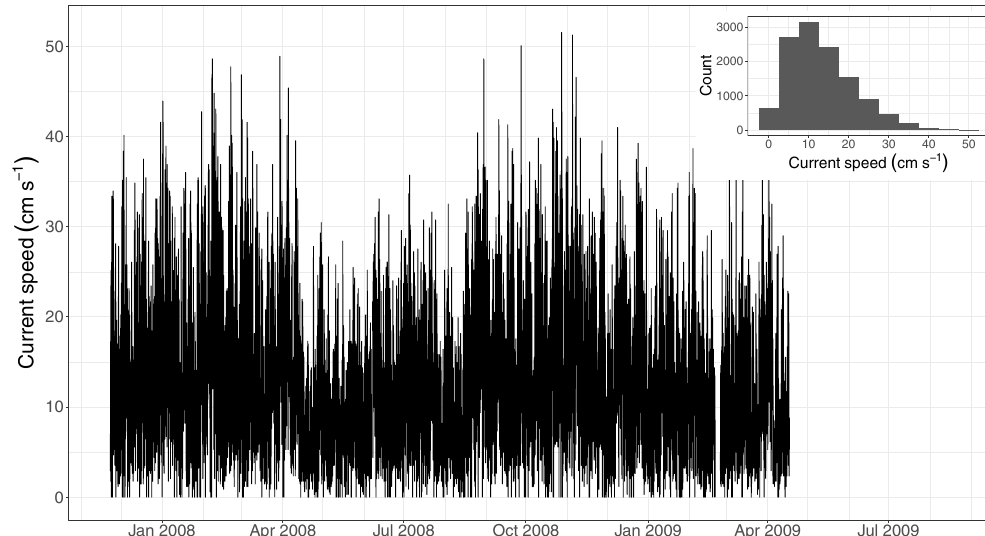
Figure 9. Measurements of current speed (cms − 1 ) at 1.5m depth. A histogram of measurements is inset.